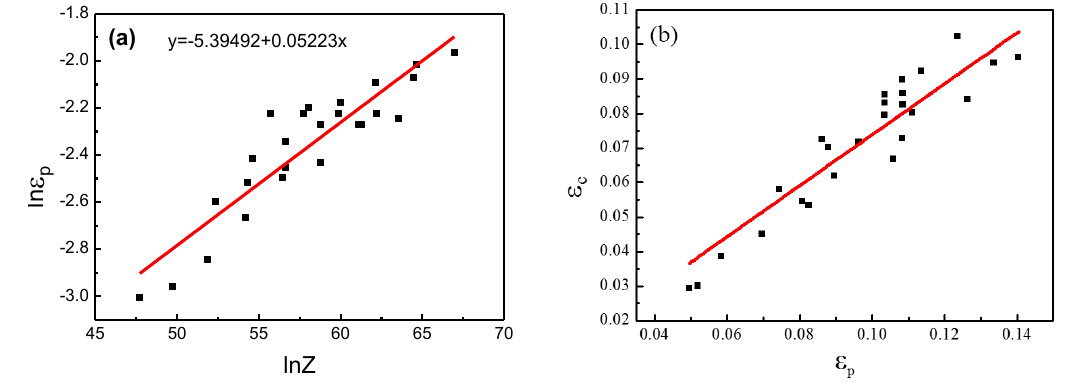
Figure 10. The plots of ( a ) ln ε p -ln Z and ( b ) ε c - ε p .